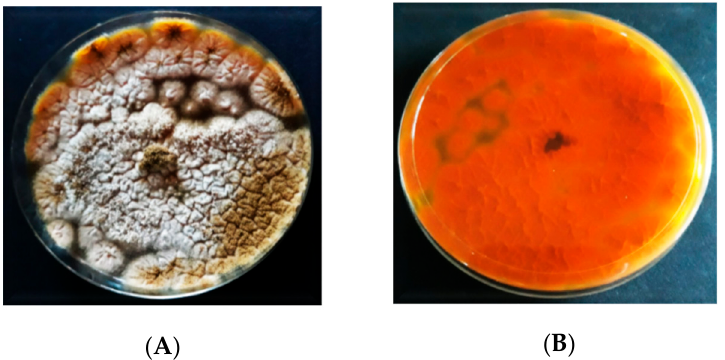
Figure 4. Colony morphology of A. flavus on Aspergillus flavus and Aspergillus parasiticus agar (AFPA); ( A ) = obverse, ( B ) = reverse.